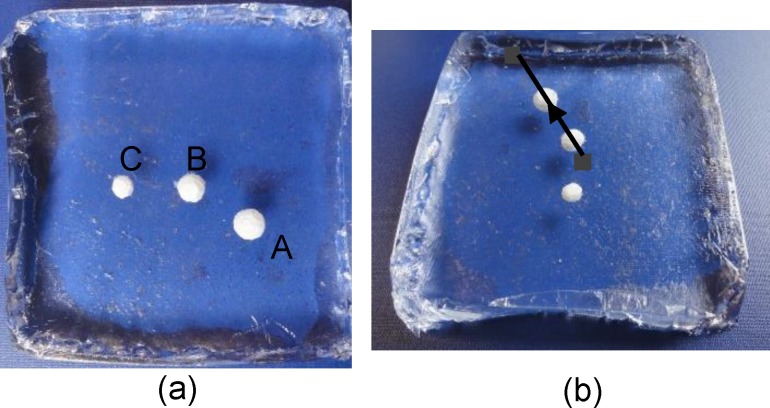
Silicone soft-tissue phantom.(a) the locations of the 3 embedded nodules are highlighted (A, B, C); (b) an operator remotely palpated the phantom tissue by using the same trajectory, which covers nodules A and B, guided by the two black tags.